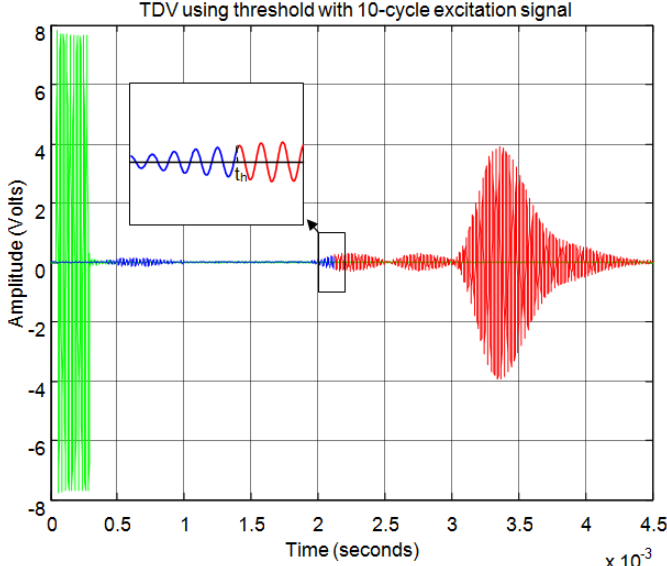
Figure 27. Start time using threshold for an echo formed by three overlapping